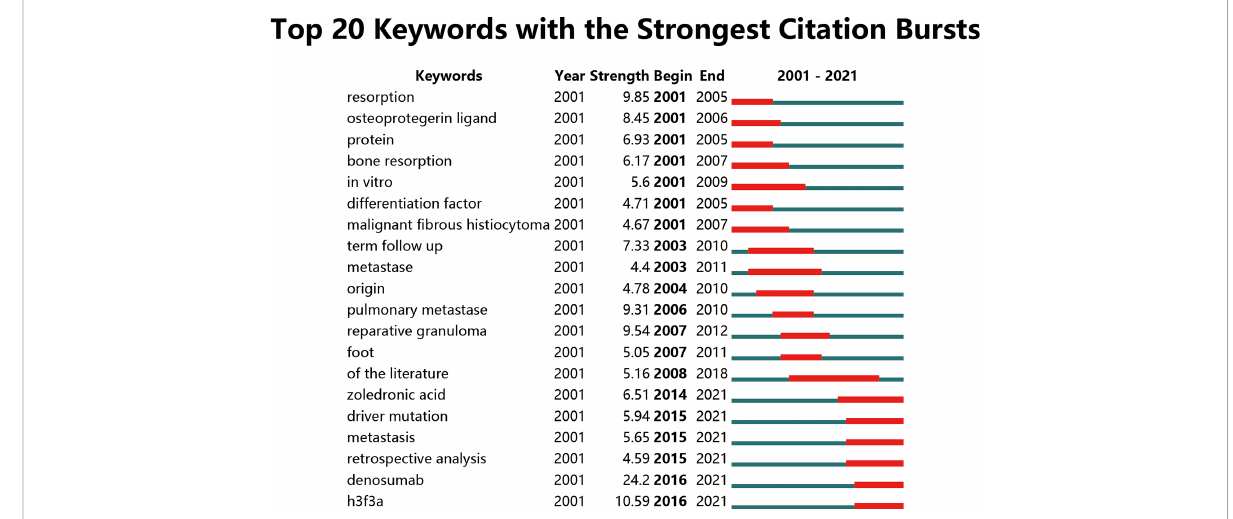
FIGURE 9 Top 20 keywords with the strongest citation bursts. Keywords with the strongest citation bursts in the scienti fi c literature were analyzed and visualized in the keyword ’ s bursts map. The lines in red stood for the burst detection years. Keywords with red lines extending to the latest year can indicate the research frontiers in a short period of time in the